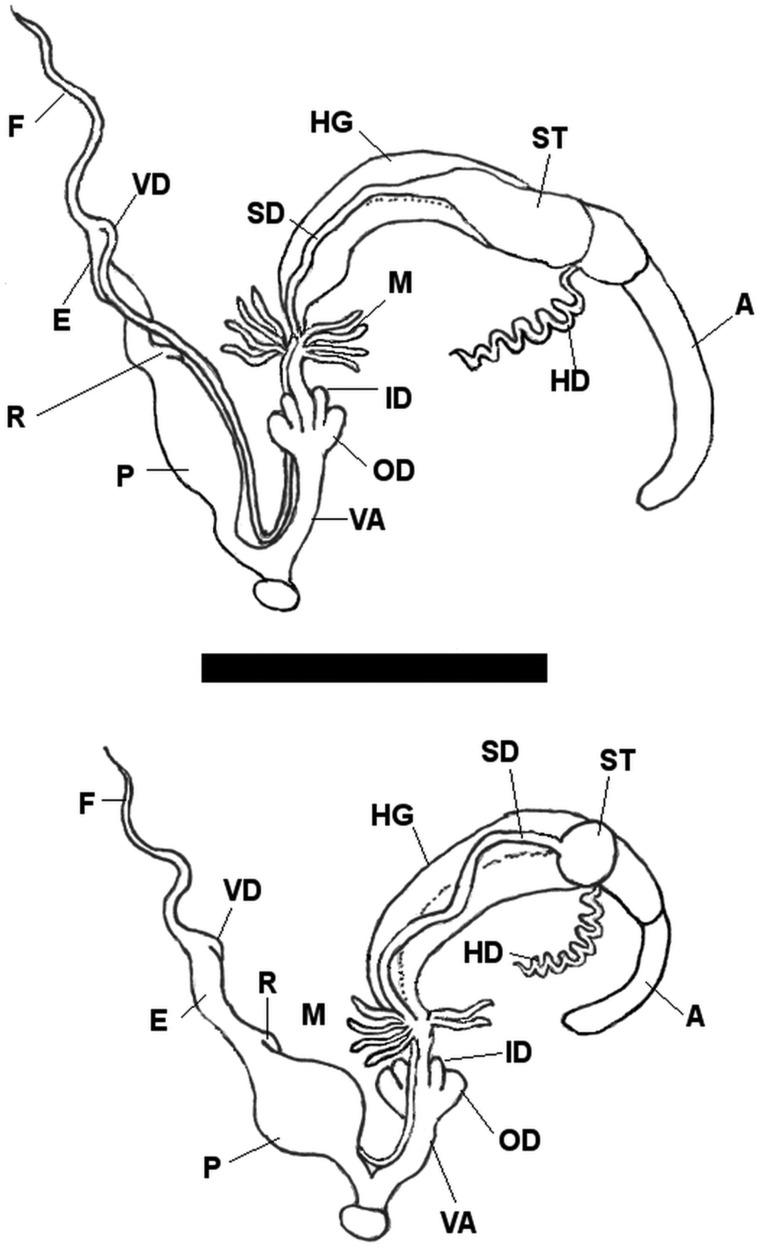
Two variants of Trochulus hispidus genitalia. The upper one shows a fusiform penis, elongate spermatheca and four pairs of mucous glands, the lower one a bulbous penis, round spermatheca and three pairs of mucous glands. Abbreviations: A, albumen gland; E, epiphallus; F, flagellum; HD, hermaphroditic duct; HG, hermaphroditic gland; ID, inner dart sacs; M, mucous glands; OD, outer dart sacs; P, penis; R, retractor muscle; SD, spermathecal duct; ST, spermatheca; VA, vagina; VD, vas deferens. Scale bar = 5 mm.